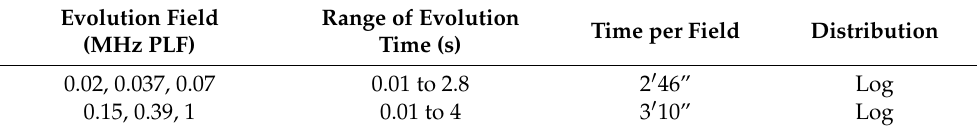
Table 1. Parameters of NMRD profile